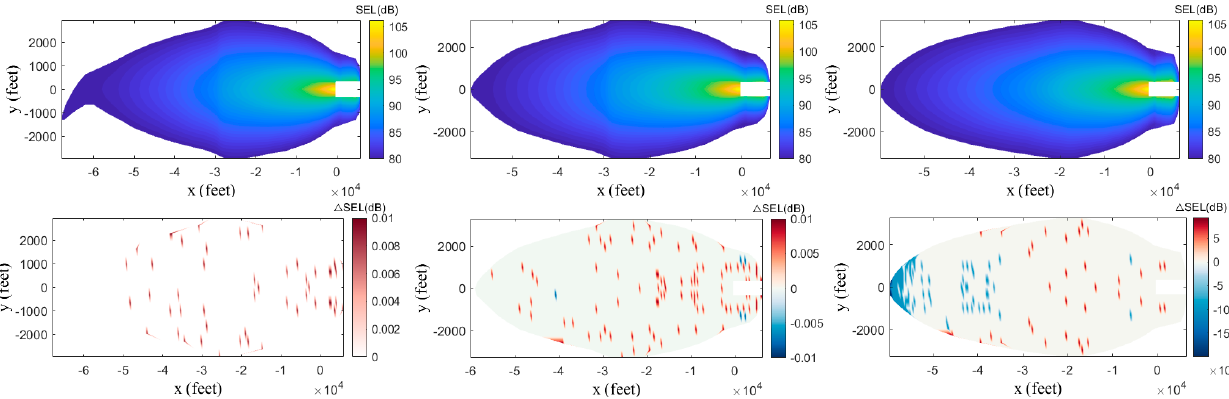
Figure 6. Noise contour map (top) and corresponding error (bottom) for JETFAC (left), JETWAC (center), PROPAC (right) cases.